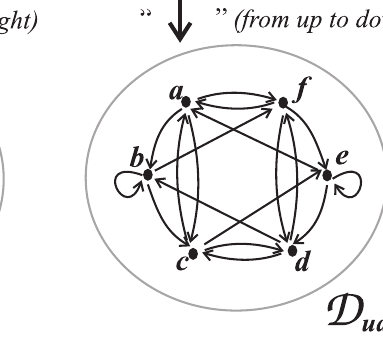
Figure 8. Digraphs D ud and D lr